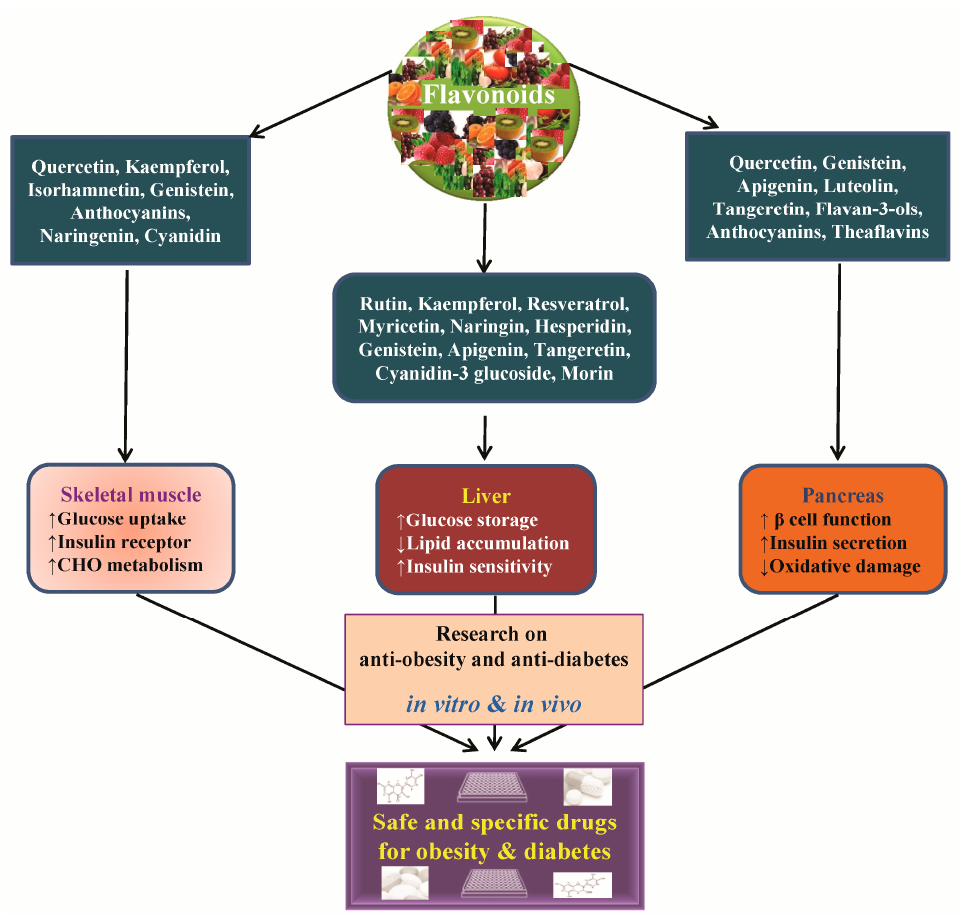
Figure 4. Graphical presentation of anti-obesity and anti-diabetes effect of flavonoids and their subsequent effects in skeletal muscles, liver, and pancreas to induce glucose uptake, increase insulin secretion, and reduce oxidative damage and lipid accumulation. Research on the molecular action of flavonoids would help in developing new strategies for discovery of safe and specific anti-obesity and anti-diabetic drugs. CHO: Carbohydrate. ( ↑ ) Increase, ( ↓ ) Decrease. 4. Anti-Obesity and Anti-Diabetic Properties of Flavonoids and Their Molecular Functions